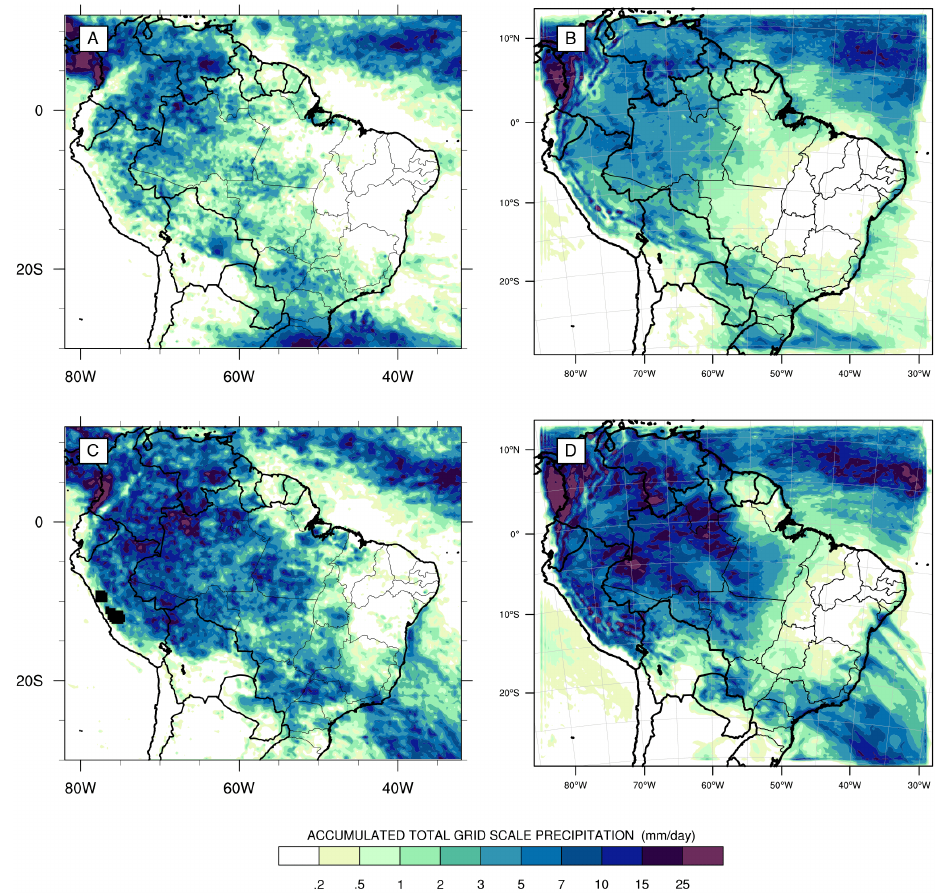
Figure 3. Maps of averaged precipitation (mmday − 1 ). ( a and c ) are derived from the TRMM 3B42 satellite product (Huffman et al., 2001, 2013). ( b and d ) from WRF-Chem model runs. ( a and b ) for Phase I (6–22 September 2012), ( c and d ) over Phase II (23–30